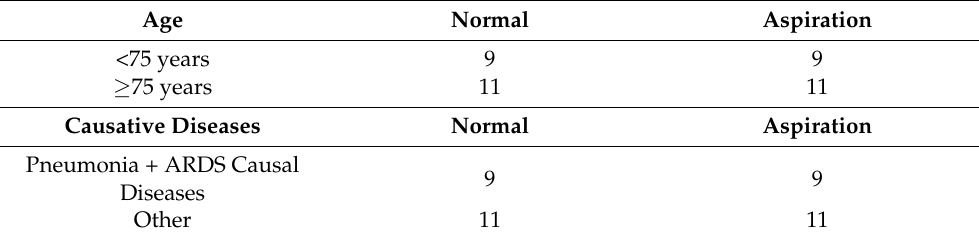
Table 5. The Mantel–Haenszel Chi-squared test with continuity correction was performed on each time point after correcting the confounding factors. χ 2 -Value p -Value MTP value (at 6 h) 6.125 0.0133 MTP value (at 24 h) 2.50